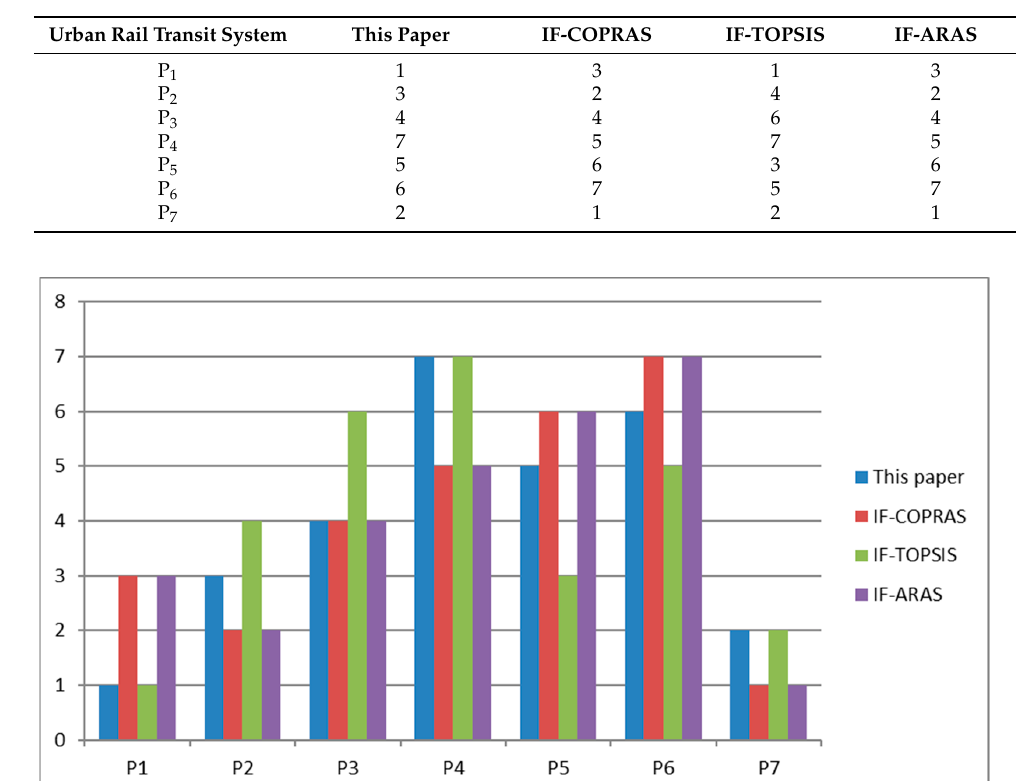
Table 14. The ranking under different evaluation methods.